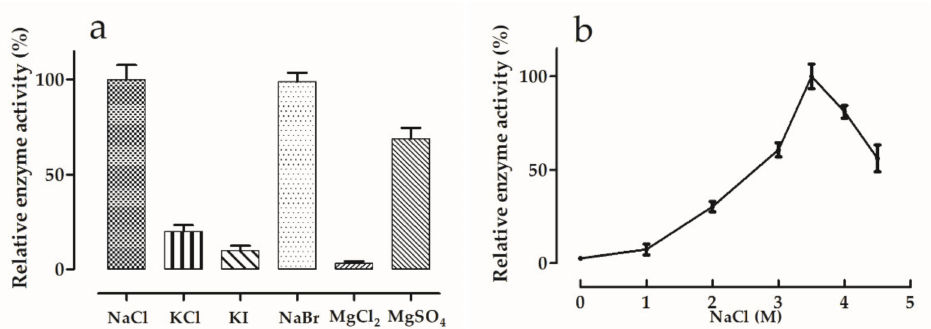
Figure 4. Effects of ( a ) different salt types at 3.5 M concentrations and ( b ) varying NaCl concentrations on Hmc Isc activity. Error bars represent standard error values for three replicates. Activities are expressed as a percentage of the maximal activity. An optimal T of 45 ◦ C and an optimal pH of 7.0 were chosen for the salt optimization. Sucrose concentration was 150 mM, and reaction time was 24 h.